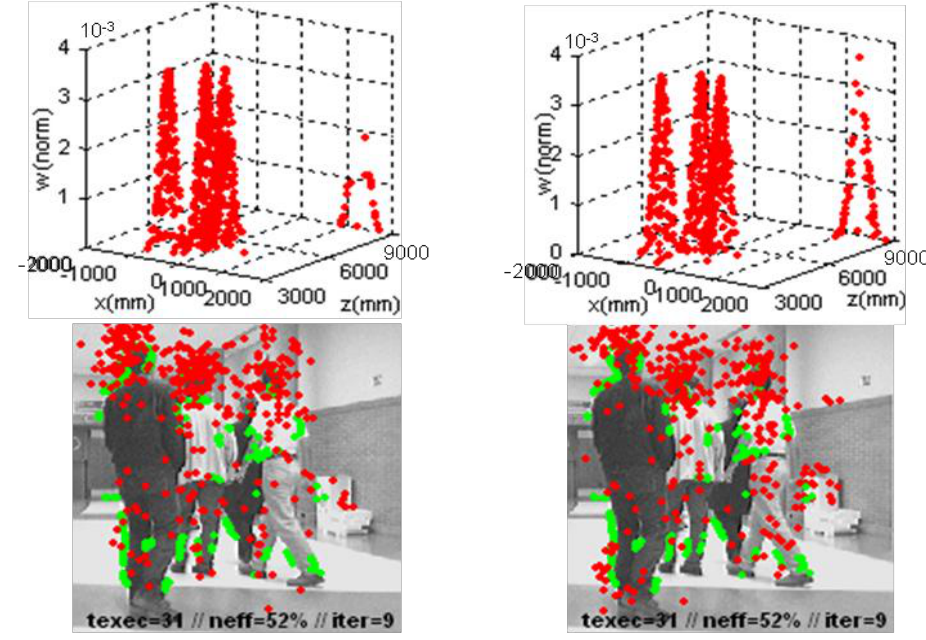
Figure 12. Results of the multi-tracking process in a real experiment using the proposed XPFCP (left column of images), and the same results using an input data set not segmented in classes at the re-initialization and correction steps (right column of images).